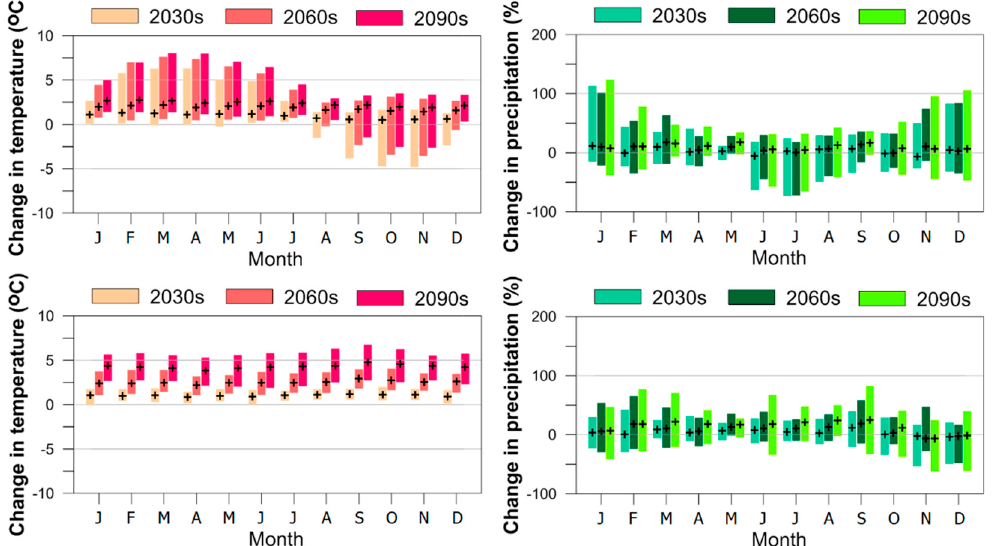
Figure 3. Changes of monthly temperature (°C) and precipitation (%) averaged from the results of 109 subbasins in 3 future periods (2010–2039, 2040–2069, and 2070–2099) referred to the baseline (1976–2005) in representative concentration pathway (RCP) 4.5 ( upper half ) and RCP 8.5 ( lower half ). The columns show the range of the change for 13 GCMs, and the black plus signs show the multi-model ensemble (MME) mean of the estimations.